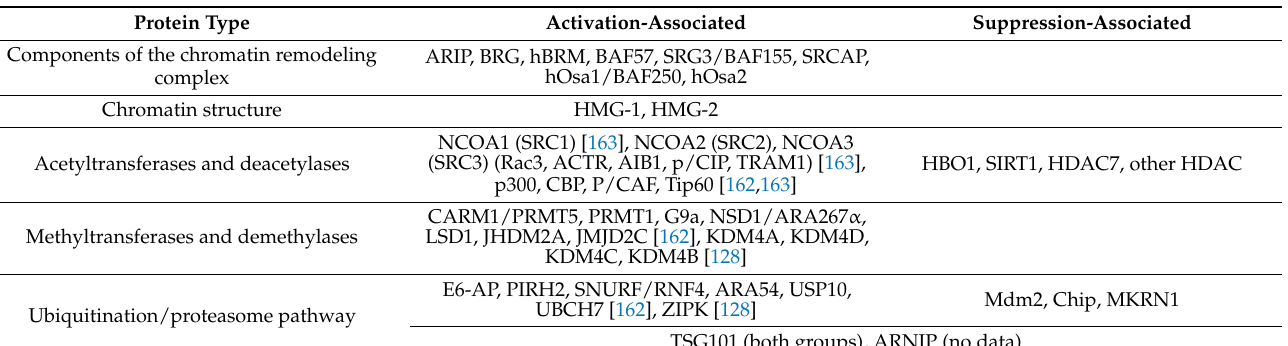
Table 3. The interactome of AR (citation: if not